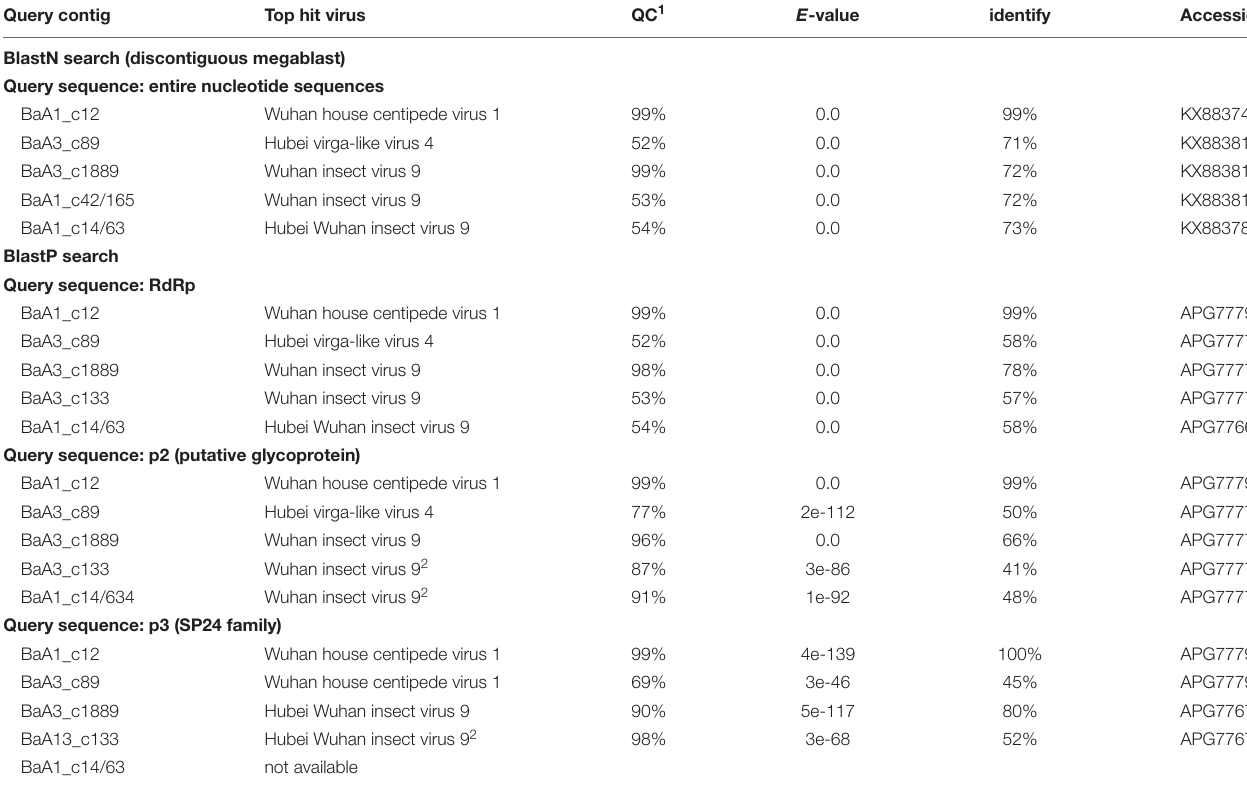
TABLE 3 | Nege/kita-like virus sequences identified from the barley aphid transcriptomes using Blast search. Query contig Top hit virus QC 1 E